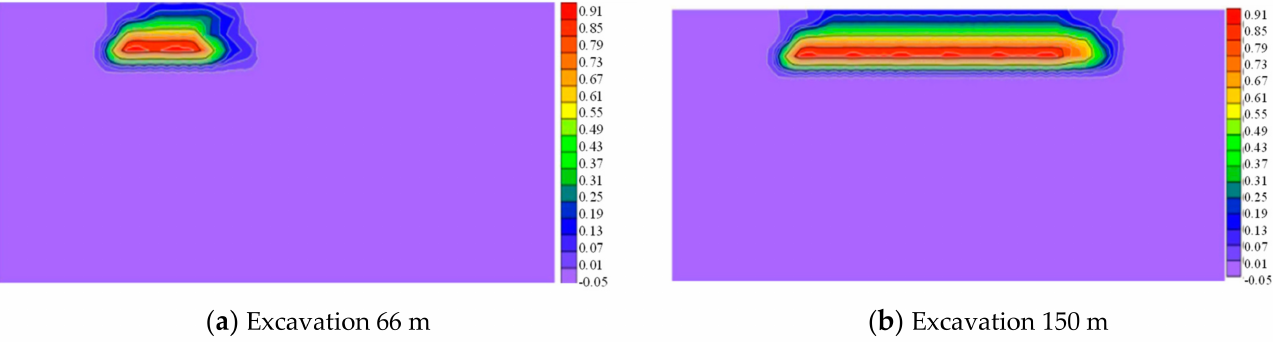
Figure 7. Evolution characteristics of the displacement field of the strata during the mining of the 3# coal